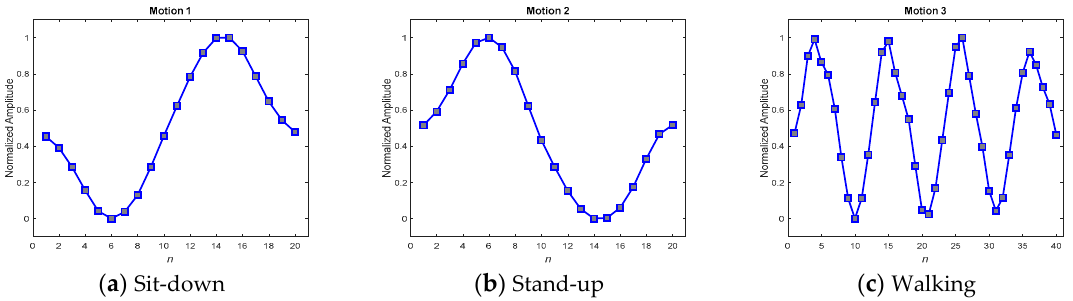
Figure 14. Averaged MPPs for motions 1–3, generated by the convolutional equalizer.